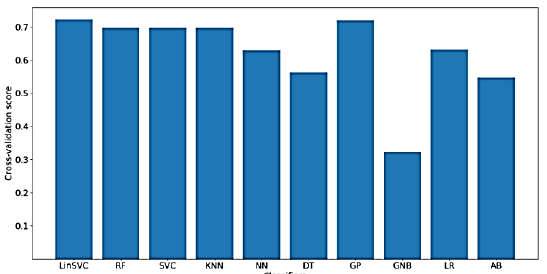
Figure 14. Performance of implemented classifiers for the classification of FA scores using NoOutliers data and only time-domain features.